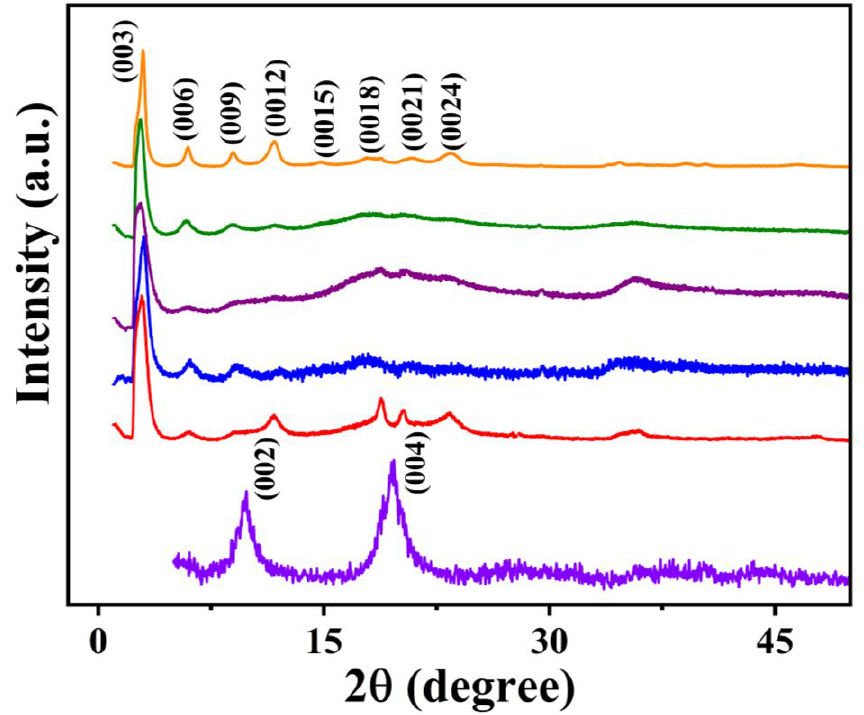
Figure 5. PXRD patterns of Li-Mg-Al-NO 3 LDH (data in violet) and Li-M-Al-DBS LDHs (M = Mg (data in red), Co (data in blue), Ni (data in purple), Cu (data in olive green), and Zn (data in orange)).